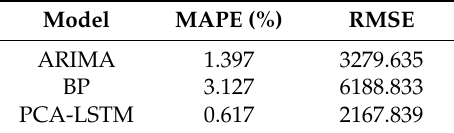
Table 4. Error analysis of forecasting result.